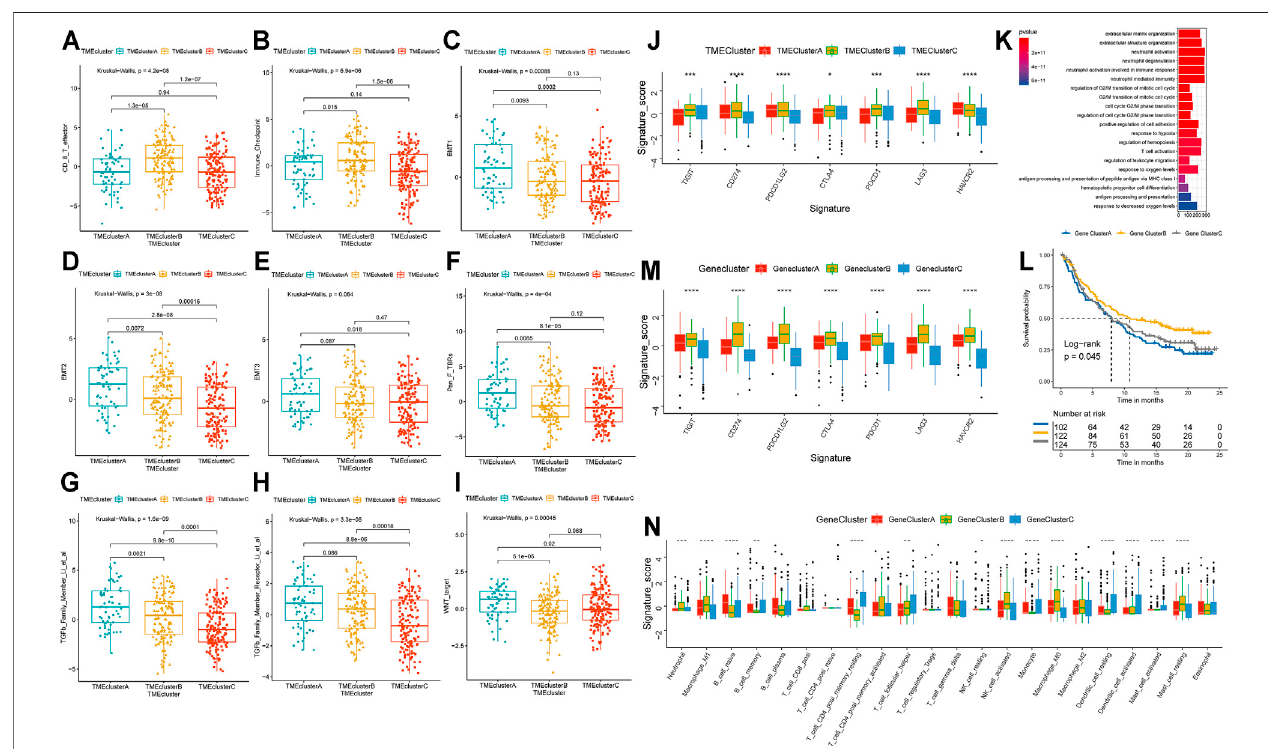
FIGURE 2 | Molecular characterization of TME-Clusters and identi fi cation of Gene-Cluster. (A) CD8 + T cell effector, (B) Immune checkpoint signature, (C – E) EMT- related signature, (F) . Pan_F_TBRs signature, (G) TGFb Family Member signature, (H) TGFb Family Member Receptor signature, (I) WNT target signature. (J) Immune checkpoints expression in TME-Clusters. (K) GO enrichment analysis of the TME-related genes. (L) Kaplan – Meier curves for Gene-Clusters. (M) Immune checkpoints expression in Gene-Clusters. (N) Immune in fi ltration cells expressed in Gene-Clusters. The range of p values are labeled above each boxplot with asterisks (* p < 0.05, ** p < 0.01, *** p < 0.001, **** p <